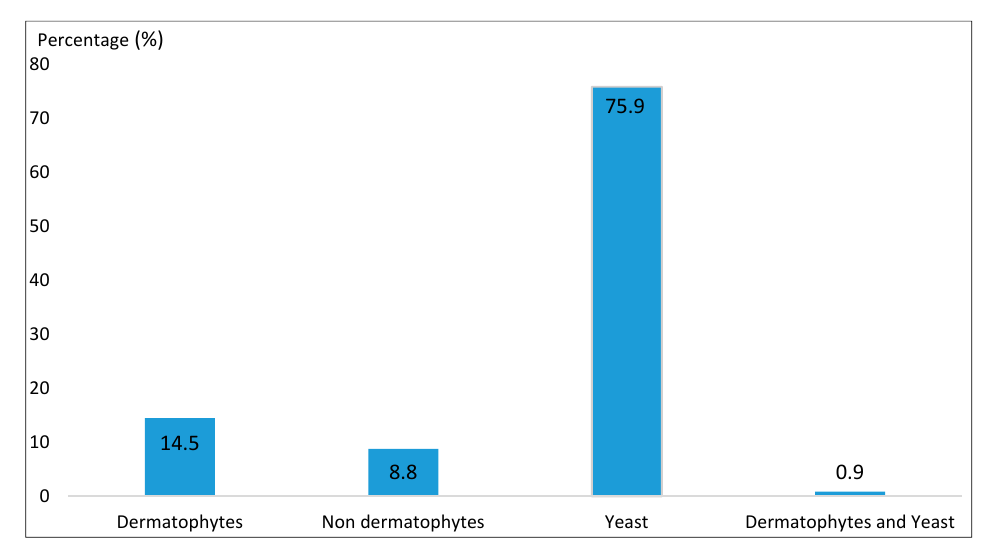
Figure 1. Identified pathogens groups.